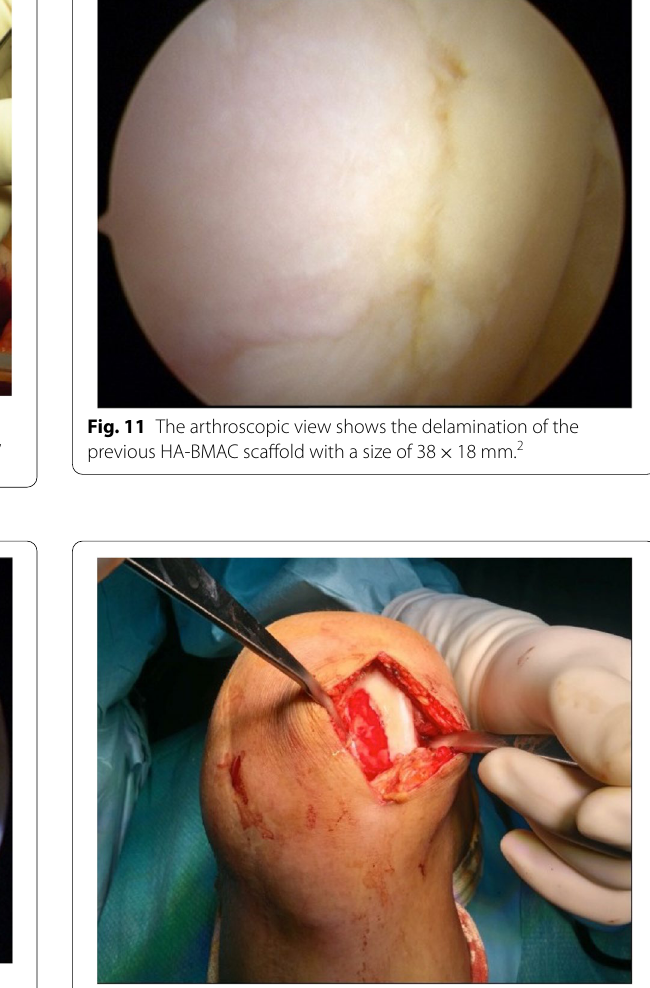
Fig. 12 The chondral lesion was delaminated, and a new cartilage repair with HA-BMAC was performed